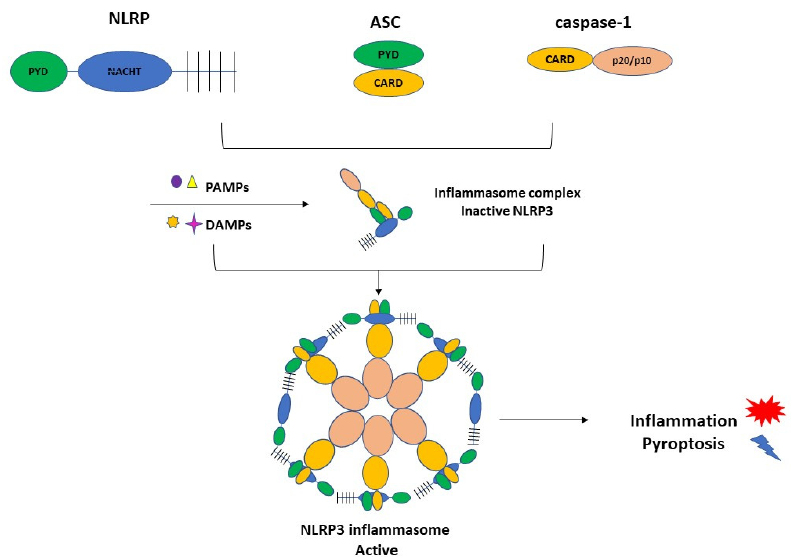
Figure 1. The NLRP3 inflammasome consists of NLRP3, ASC, and caspase-1. NLRP3 is composed of C-terminal leucine-rich repeats (LRRs), a central nucleotide-binding and oligomerization domain (NACHT), and an N-terminal pyrin domain (PYD). ASC is also termed Pycard, containing an N- terminal PYD and a C-terminal caspase recruitment domain (CARD). The last element of the CARD and caspase domains. PAMPs and DAMPs can activate the inflammasome complex and triggers inflammation and pyroptosis.